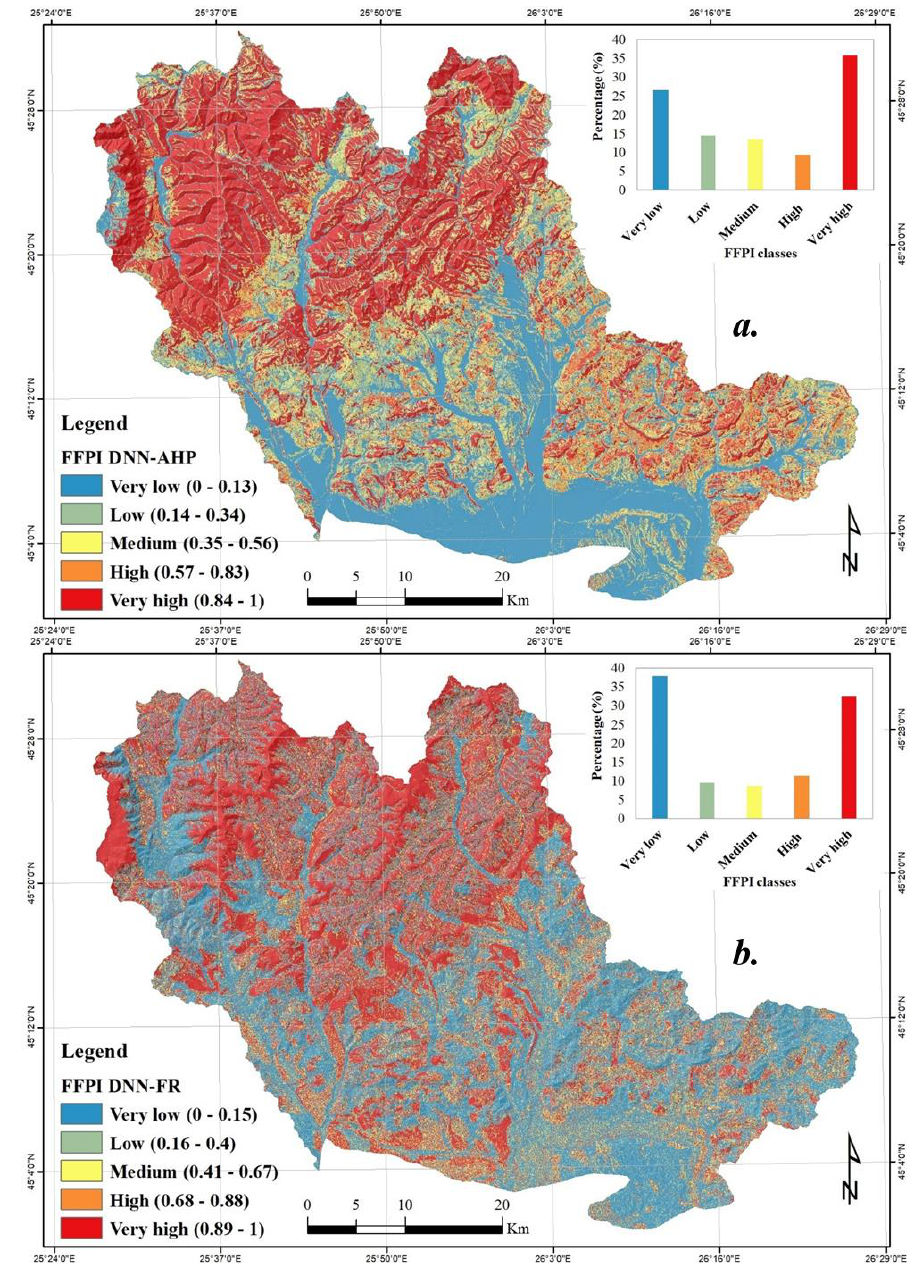
Figure 10. Flash-Flood Potential Index (( a ) DNN-AHP; ( b ) DNN-FR).